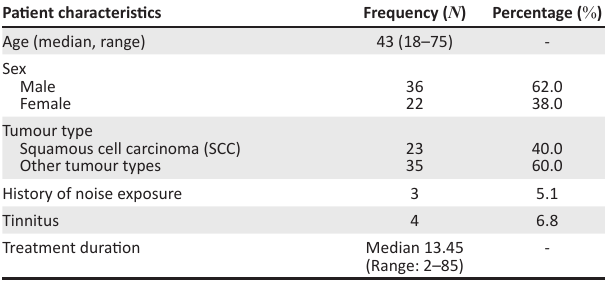
TABLE 1: Participants’ description ( n =